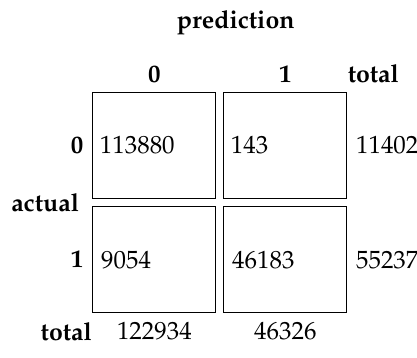
Figure 14. Confusion Matrix of